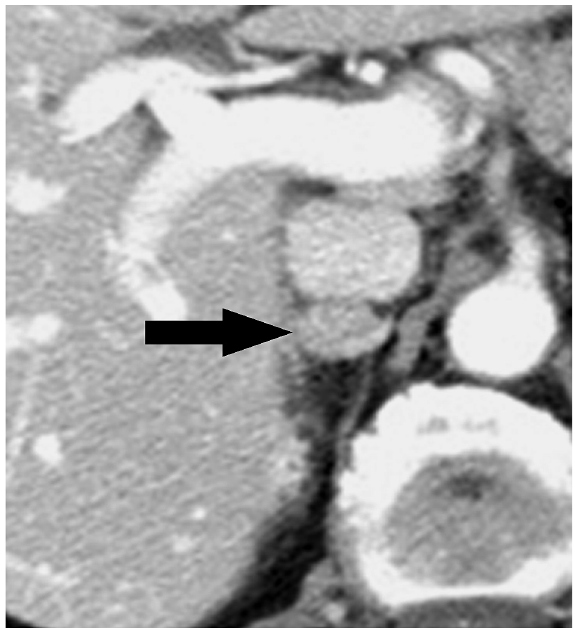
Figure 1 – Axial contrast-enhanced portal venous phase CT scan in a 76 year old woman undergoing preoperative staging of a cecal mass (Case 1 in Table-1). A homogeneously enhancing right adrenal mass (arrow) is seen, and showed less than 50% washout on delayed images (not shown). The patient proceeded to right hemicolectomy and adrenalectomy, because the working diagnosis before surgery was of possible adrenal metastasis. Surgery was complicated by hemodynamic instability and a postoperative non-Q wave myocardial infarction. Final pathol- ogy revealed a cecal tubulovillous adenoma and an adrenal pheochromocytoma.